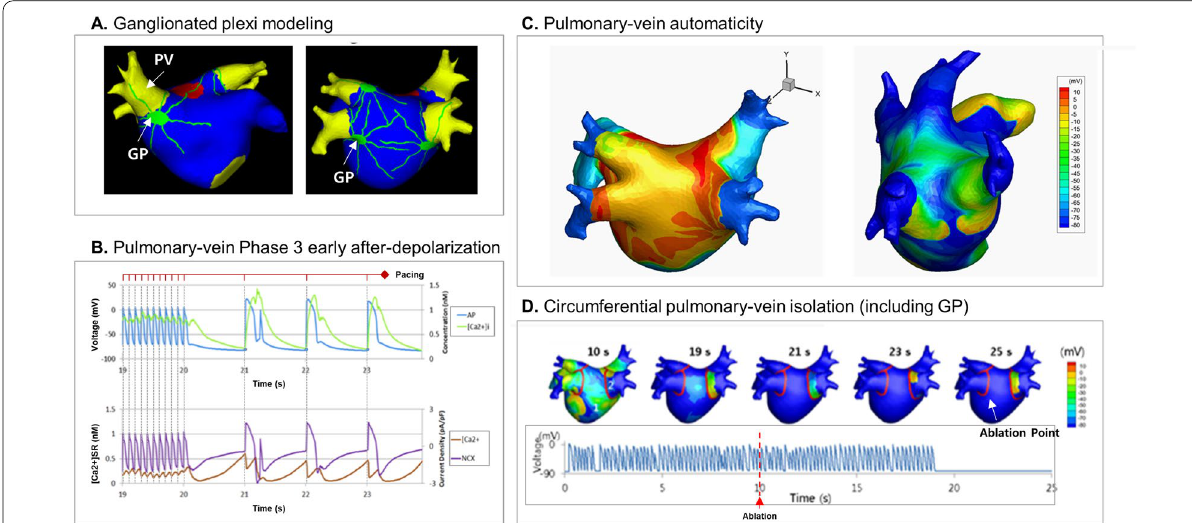
Fig. 5 Effect of PV reentry and ganglionated plexi ablation after PV triggers in Phase 3 early after depolarization via autonomic nerve modeling. AF computational modeling of cardiac autonomic nerve effects, which is difficult to perform clinically or experimentally, will enable further studies for AF initiation mechanisms. A An example of ganglionated plexi (GP) modeling. B Abnormal depolarization was observed after a change of pacing cycle length. C 3D action potential map showing pulmonary‑vein automaticity in 3D left atrium model with GP. D AF was terminated after virtual circumferential pulmonary vein isolation including GP. Images were taken from [43]